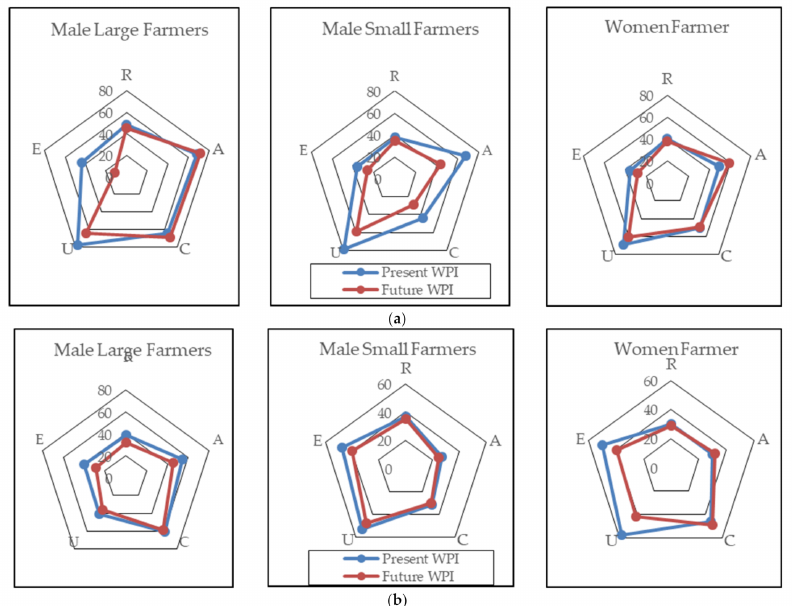
Figure 10. Present and future WPI pentagrams for ( a ) farmers in the Dhalla union and ( b ) farmers in the Saista union.